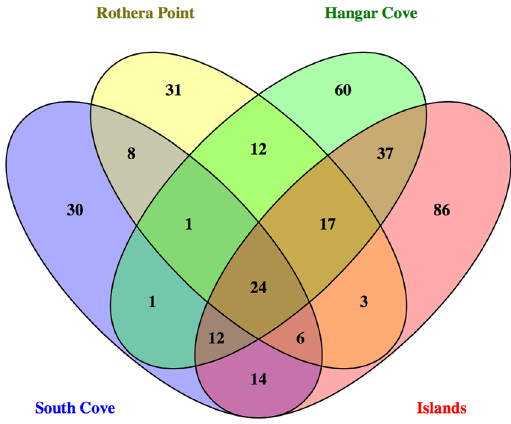
Figure 3. Venn diagram depicting OTUs that are shared or unique to each of the four sampling sites found in the Antarctica meiofaunal shallow waters. Numbers in the diagram represent the number of total OTUs found in the different samples, South Cove (blue), Islands (Red), Rothera Point (yellow) and Hangar Cove